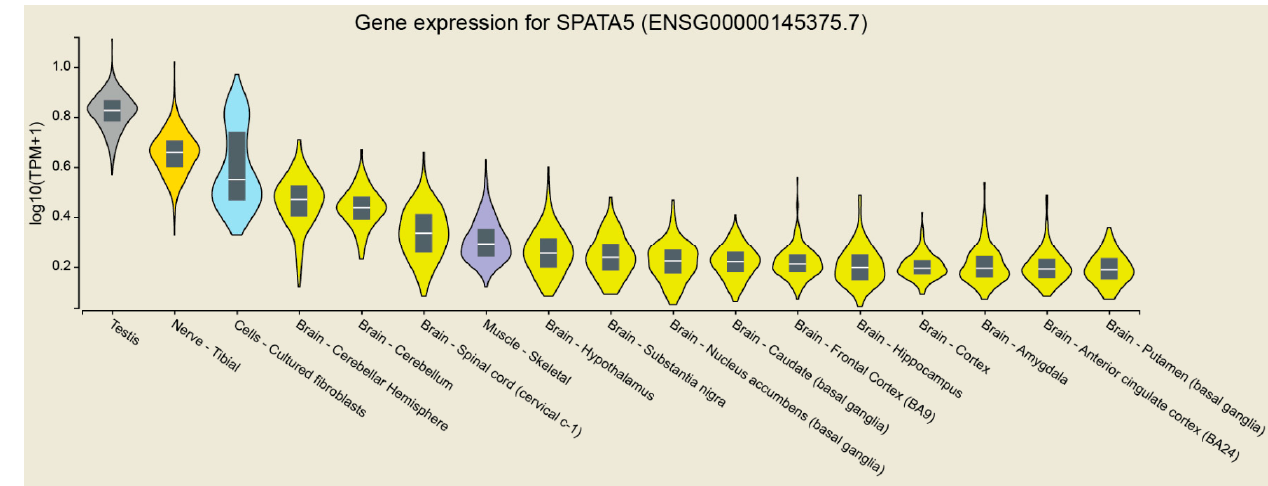
Figure 1. Gene expression for SPATA5 .